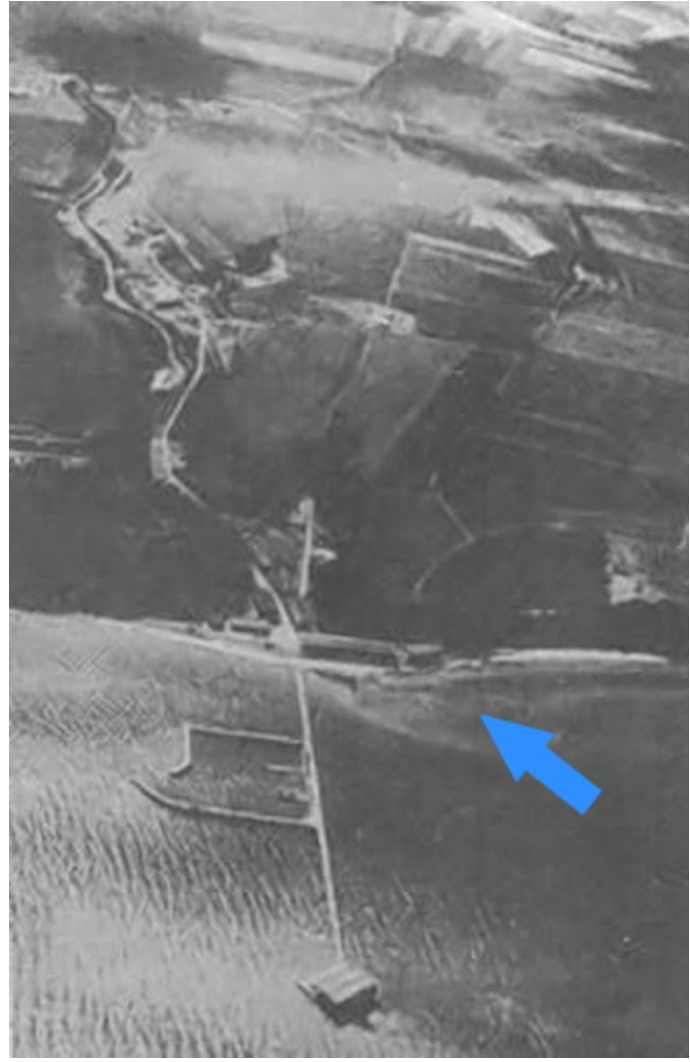
Figure 11. Torpedo station put into service in 1942. The blue arrow indicates the approximate location of KM 93.6–93.9.